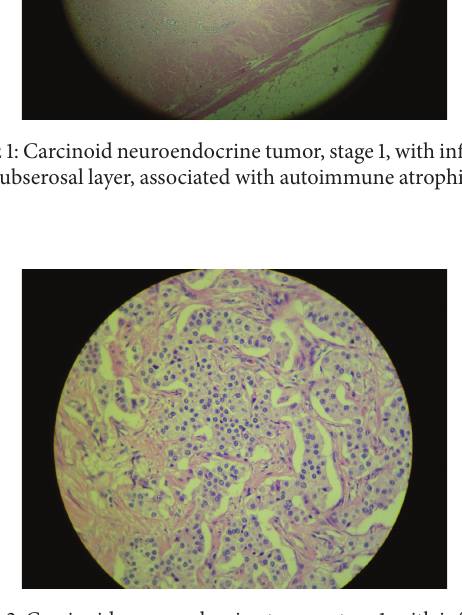
Figure 2: Carcinoid neuroendocrine tumor, stage 1, with infiltration to the subserosal layer, associated with autoimmune atrophic gastri- tis.